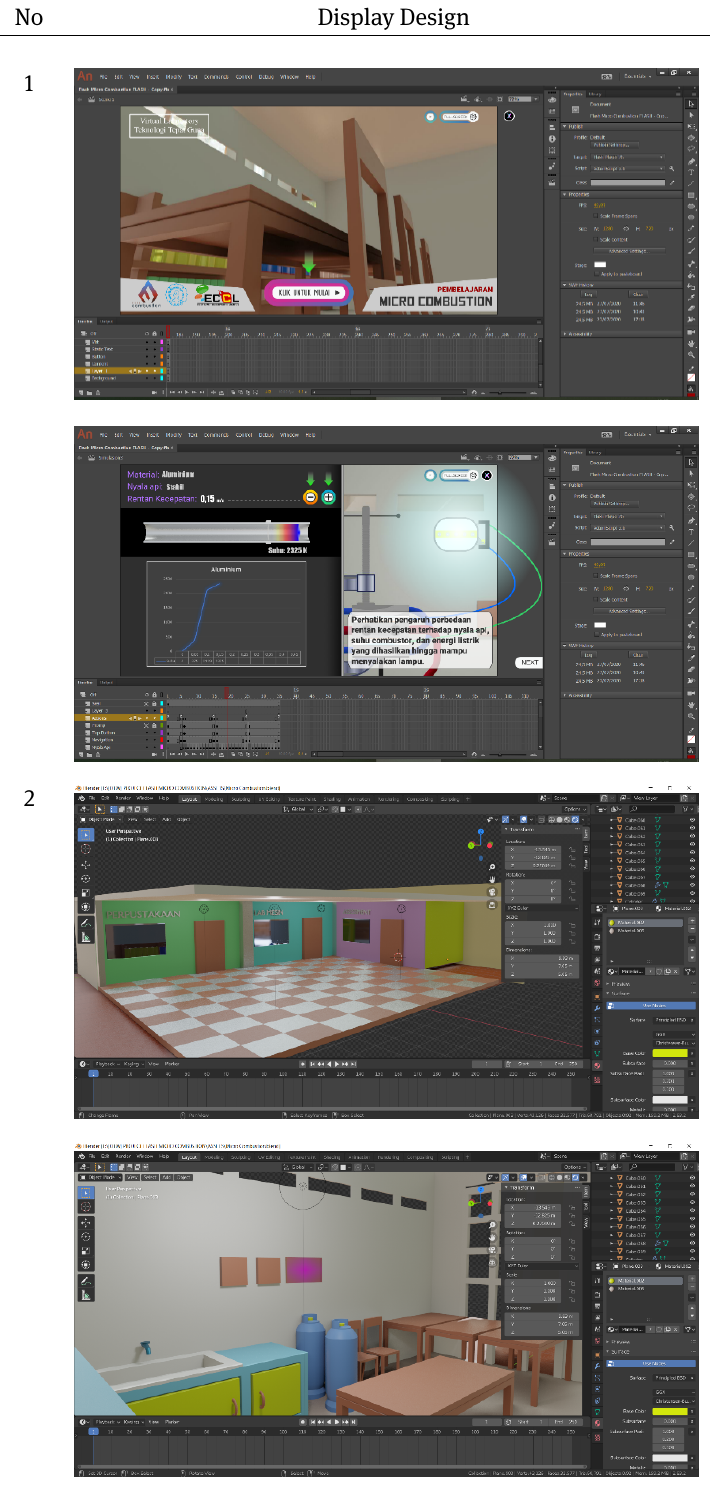
Table 3: Virtual laboratory